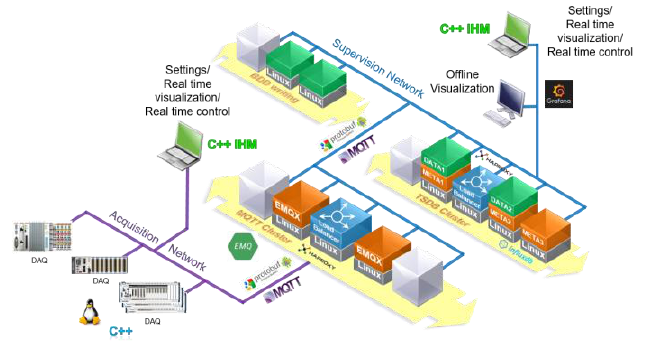
Fig. 2. CAREDAS architecture.